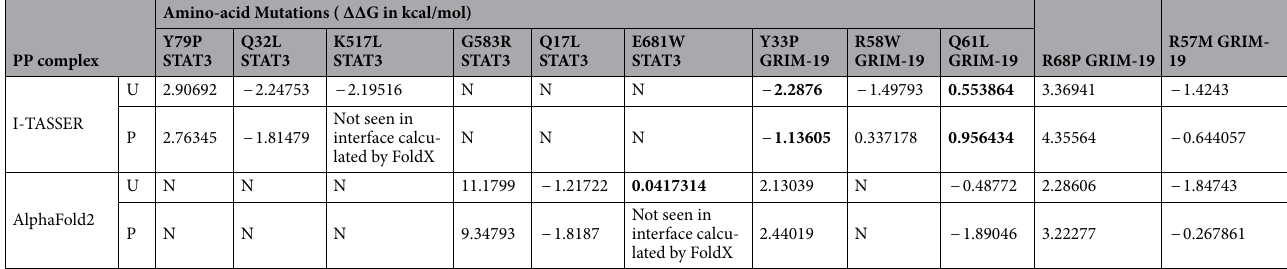
Table 5. Free energy change (ΔΔG) values upon mutation of select interfacial residues to analyse stability using FoldX. Positive values indicate destabilization. N not found in hydrogen bonds calculated by